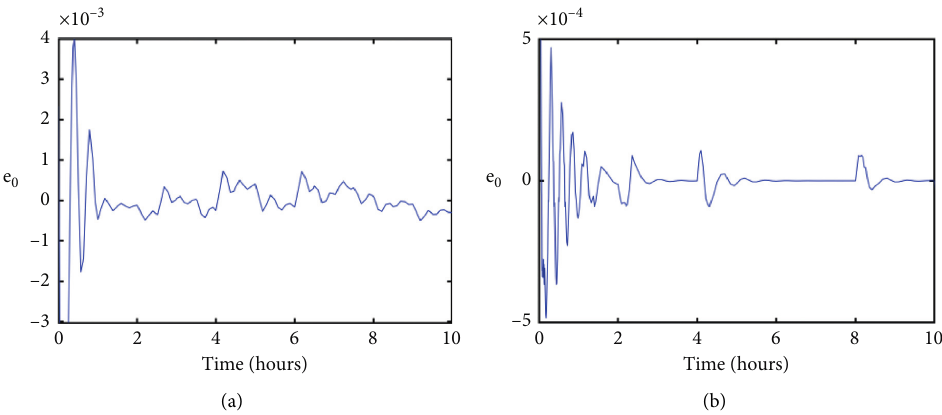
Figure 7: The variation of e under the action of (a) integral sliding mode control and (b) fuzzy integral sliding mode 0